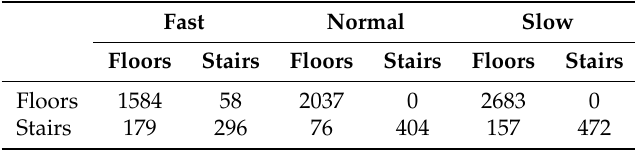
Table 3. Confusion matrix of stair